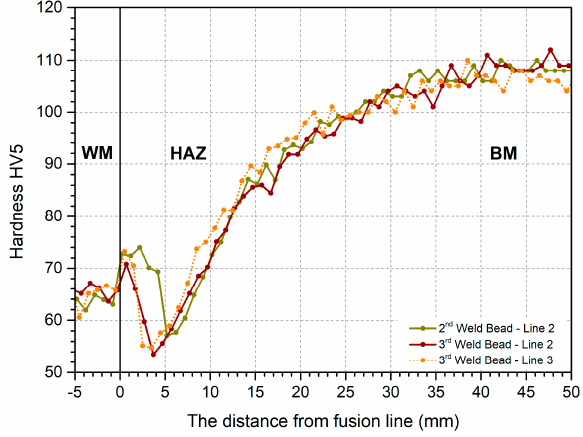
Figure 11. Measured hardness values in the weld metal, HAZ and base material for weld 1 (with preheating at 150 °C) in the zone of line 2 after application of the second and third weld beads. 2.4. Heat Treatment of Multipass Welds on Alloy AW 6061 As can be seen from the results presented in the previous chapter, welding has a significant effect on the changes in joint mechanical properties. To restore the properties in the HAZ, heat treatment must be applied. Based on the results from experiments performed on the base material (Section 2.1), heat treatment at which the highest hardness values were achieved was applied to specimens welded with both preheating temperatures. This involved solution annealing at 530 °C for 1 h and water cooling followed by artificial hardening at 160 °C (holding time 12 h), 175 °C (holding time 8 h) and 190 °C (holding time 4 h). The HV5 hardness was again measured on all samples at the same locations as shown in Figure 6. To assess the heat treatment effect (160 °C with holding time of 12 h) at different locations of the welded specimen, the hardness value courses at the locations of lines 1, 2 and 3 after welding all three weld beads with preheating at 75 °C are shown in Figure 12. Similarly, Figure 13 shows the hardness value courses at the locations of lines 1, 2 and 3 for welding with preheating at 150 °C. The courses of hardness values after welding the individual weld beads are shown as dashed lines and hardness values measured under different conditions of artificial aging are shown as solid lines.